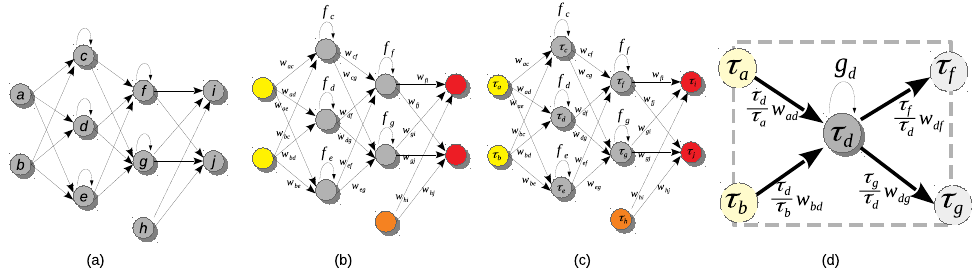
Figure 1. ( a ) Network quiver Q as introduced by [1]. ( b ) Neural network based on Q with weights W and activation functions f . Input, hidden, bias, and output neurons are in yellow, gray, orange and red, respectively. ( c ) Same neural network but with a change of basis (CoB) τ (cid:101) at each neuron (cid:101) . ( d ) Neural teleportation of the weights attached to neuron d . The resulting activation function is g d ( x ) = τ d f d ( x / τ d )